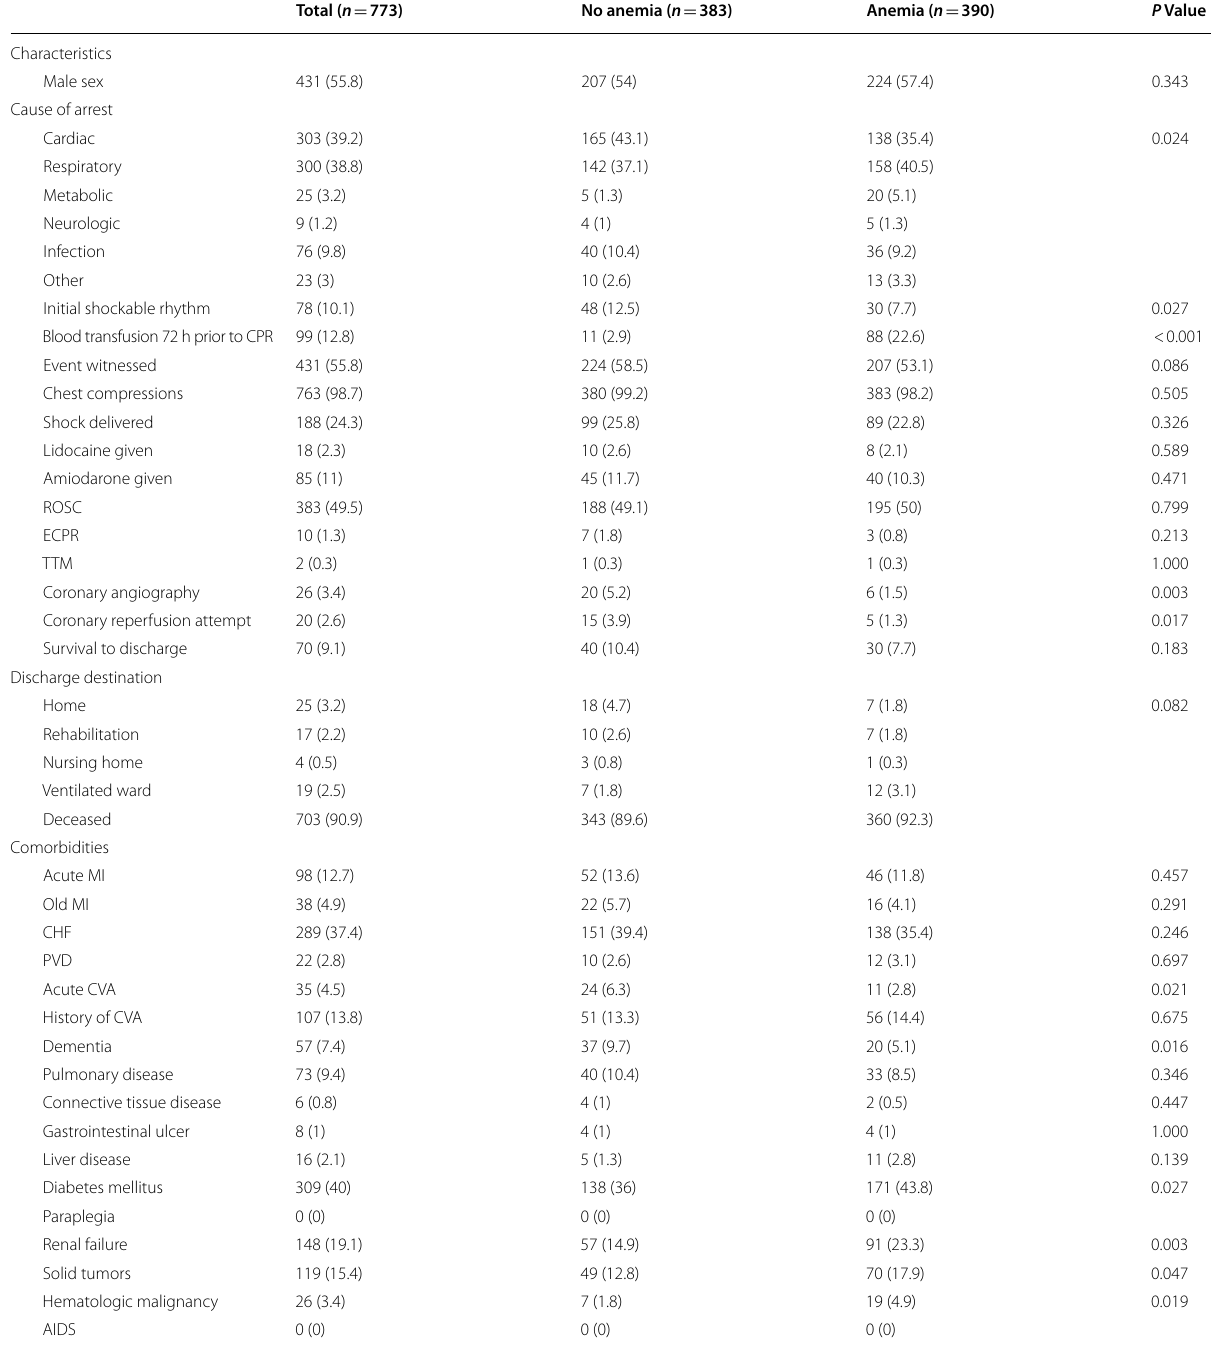
CPR cardio-pulmonary resuscitation, ROSC return of spontaneous circulation, ECPR extracorporeal cardiopulmonary resuscitation, TTM targeted temperature management, MI myocardial infarction, CHF congestive heart failure, PVD peripheral vascular disease, CVA cerebrovascular accident, AIDS acquired immune deficiency